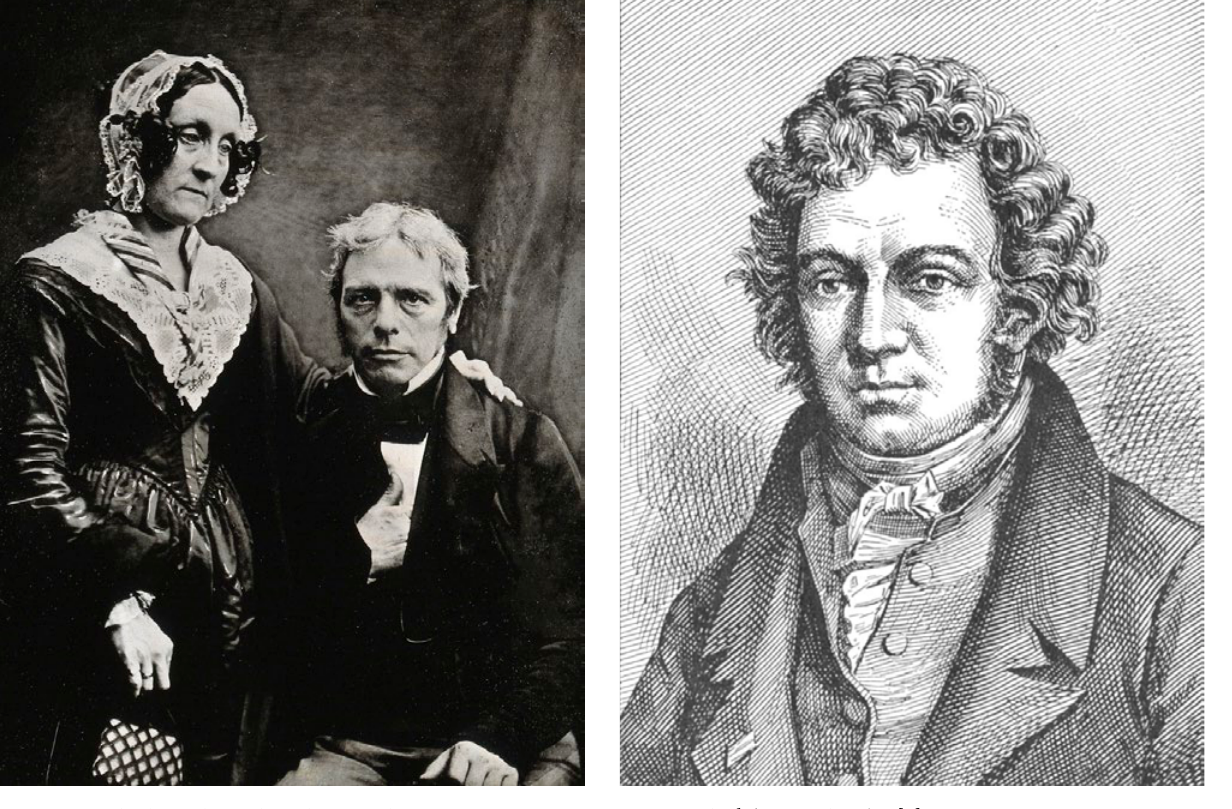
Figure 5. Michael Faraday and Sarah Barnard [7]. Figure 6. André-Marie Ampère